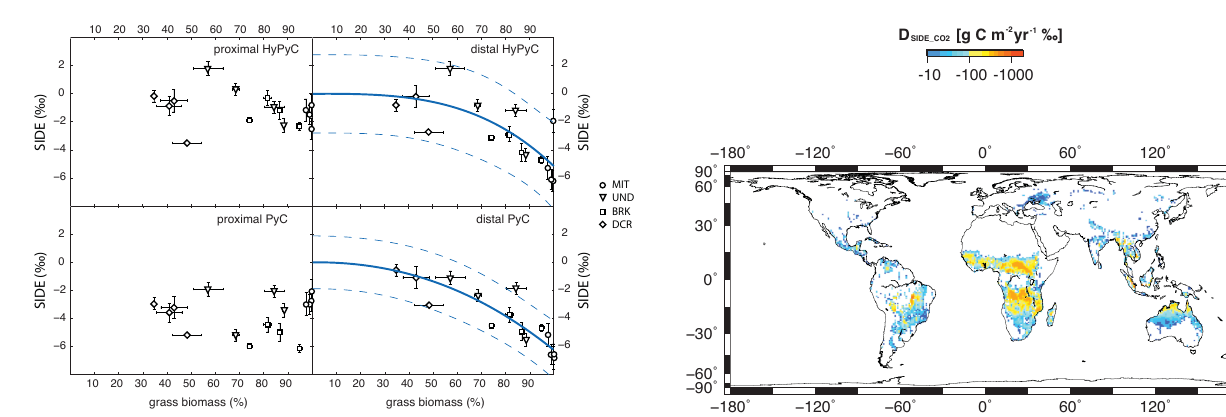
Figure 7. Global map of savanna isotope “disequilib- rium flux” (following terminology of Alden et al. (2010) = SIDE × F D SIDE_CO CO 2 bur ) of the flux of CO 2 of com- 2 bustion. The value of SIDE CO used is 0.61‰. F bur -savanna is 2 the mean annual flux of CO 2 from savanna fires, averaged over the period from 1997 to 2011 using the Global Fire Emissions Database (GFED; http://globalfiredata.org; van der Werf et al., 2010), clipped to the area where C 4 grasses > 1% (Still et al., 2003), with an estimated fraction of combusted CO 2 of 0.83 (estimated from Table